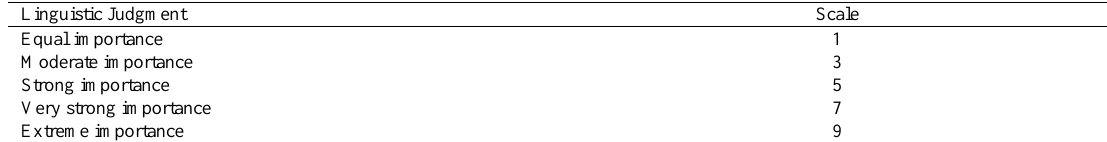
Table 1. Linguistic judgments and their fuzzy values